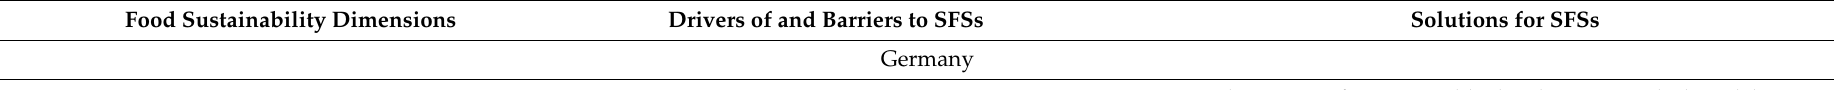
Table A2. Relevant sustainability dimensions, drivers, barriers, and solutions related to SFSs in the national legislative/policy documents according to the critical frame